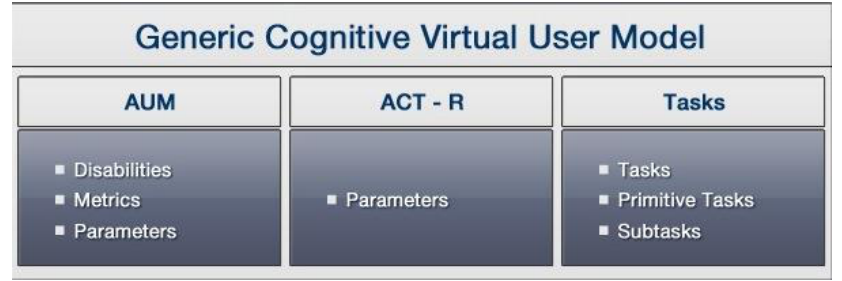
Figure 2. Information needed to generate the Generic Cognitive Virtual User Model.